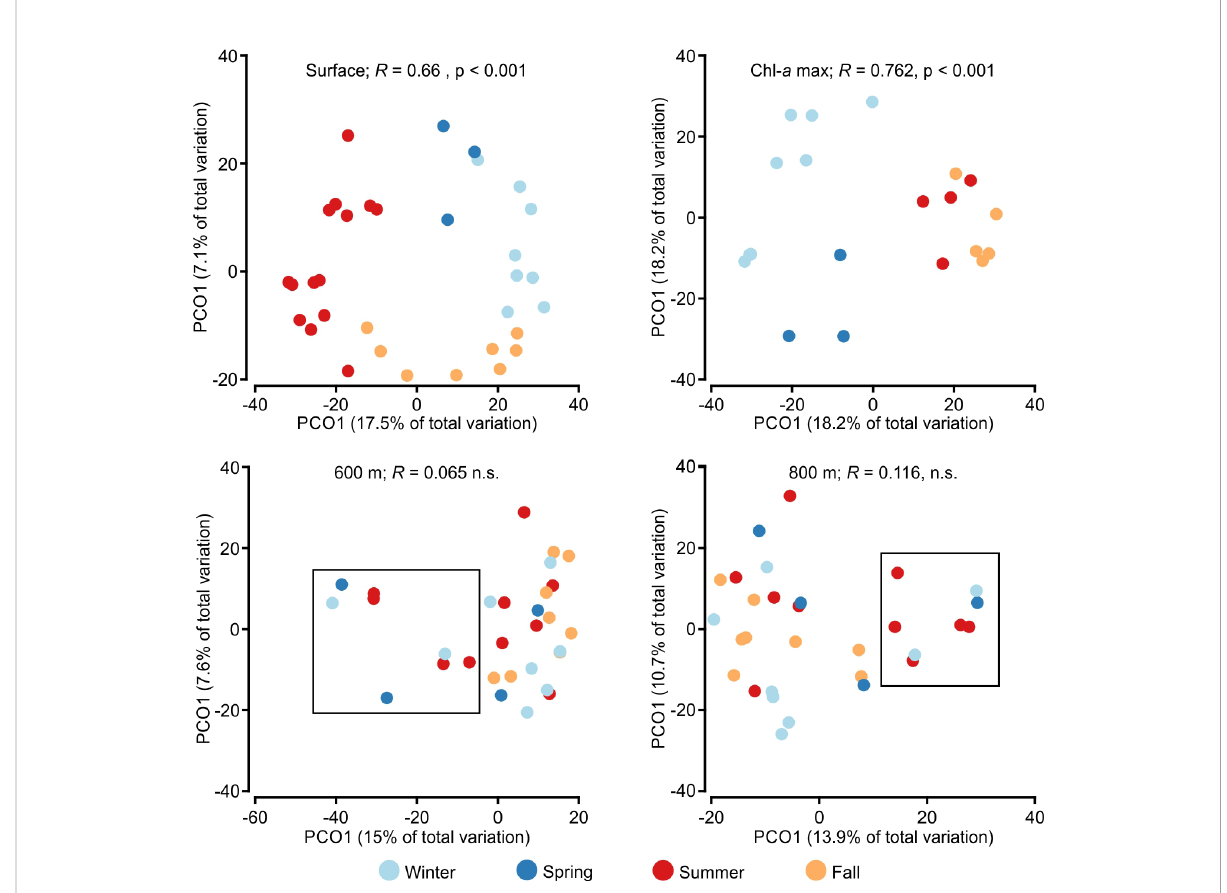
FIGURE 6 PCoA ordinations for samples from surface (upper left), Chl- a maximum (upper right), 600 m depth (lower left) and 800 m depth (lower right), based in Bray-Curtis distances, with ANOSIM R values for factor “ seasons ” indicated for each graph, and colors indicating seasons. In the epipelagic, a seasonal signal was detected, especially in the upper layers. In the mesopelagic (lower panels) no seasonality was observed, and samples diverging from the center core at these depths corresponded however to the uplifting events due to the passage of hydrographic features (within the